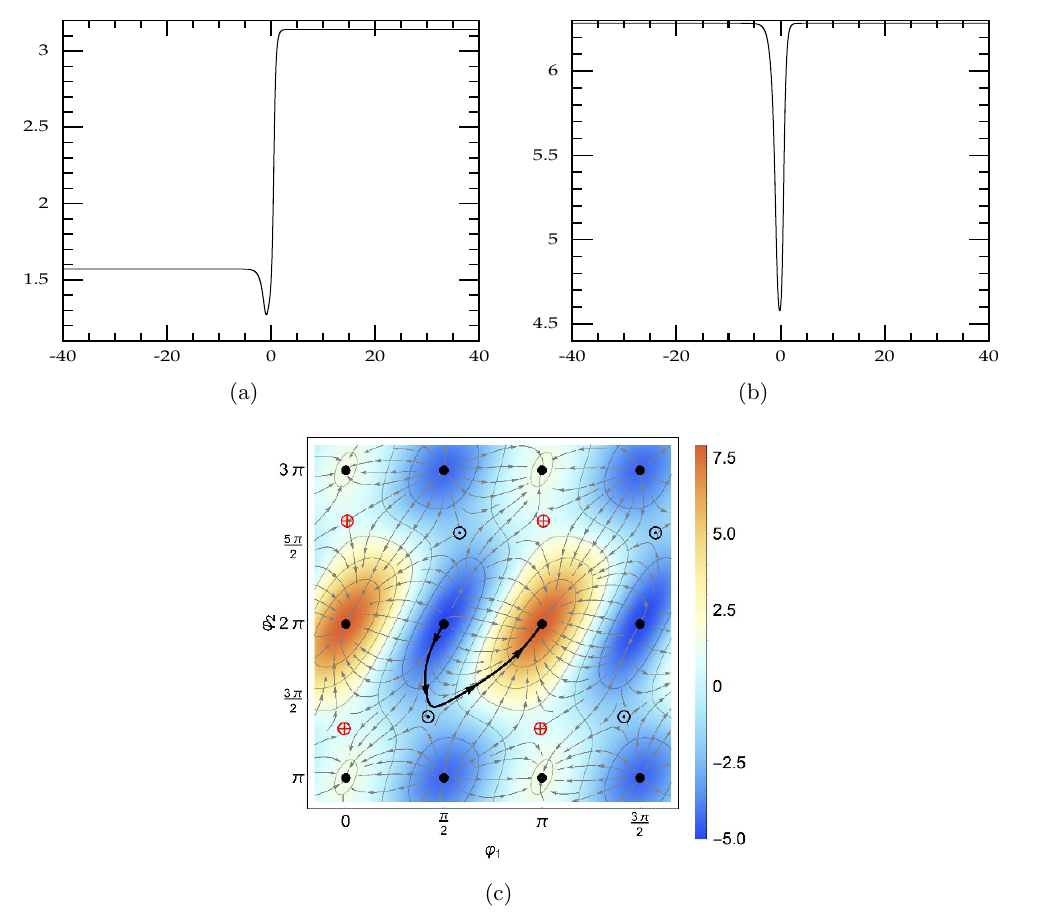
Figure 17 . SO(5) (cid:12)elds | case IV; (a) ’ 1 and (b) ’ 2 , and (c) ~ r (cid:17) U (cid:0) (cid:13)ow. Black dots stand for maxima and minima (7.5) of the pre-potential, (cid:12) for its saddle points (7.6) and (cid:8) for saddle points